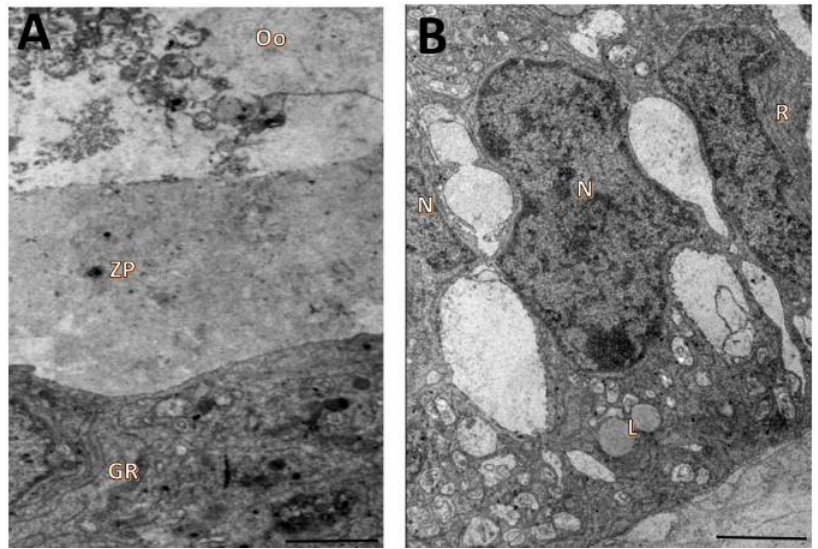
Figure 6. Ultrastructural characteristics of oocytes ( A ) and granulosa cells ( B ) from secondary follicles after 18 days of in vitro culturing in TCM 199 + supplemented with 25 mM NAC. Ooplasm (Oo), zona pellucida (ZP), nucleus (N), lipid droplets (L), granulosa cells (GR). Scale bar: 100 µm.